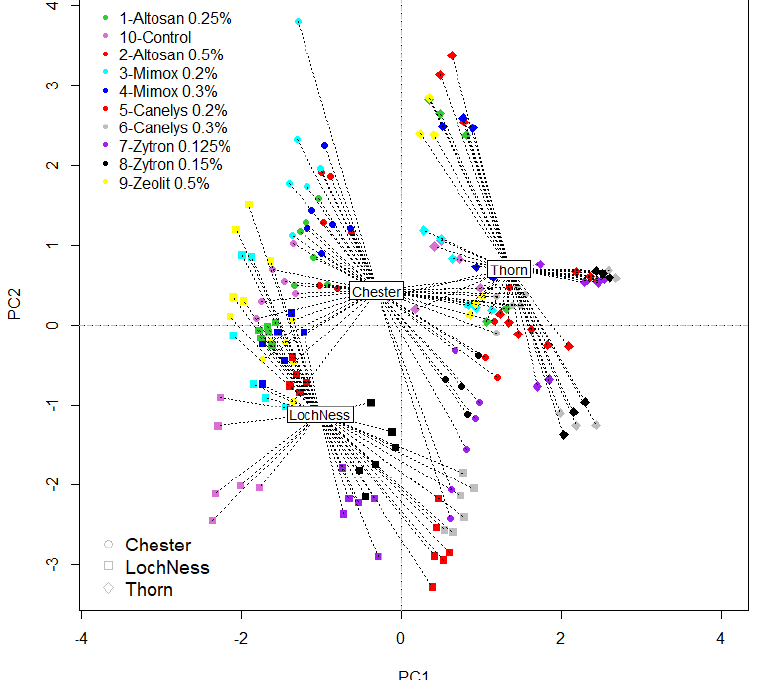
Figure 2. PCA treatment overview in organic blackberry rust disease control. Variants tested: V1- Altosan 0.25%; V2-Altosan 0.5%; V3-Mimox 0.2%; V4-Mimox 0.3%; V5-Canelys 0.2%; V6-Canelys 0.3%; V7-Zytron 0.125%; V8-Zytron 0.15%; 9-Zeolite 0.5%; V10-Control. A full description of treat- ment recipes is provided in Table 12.